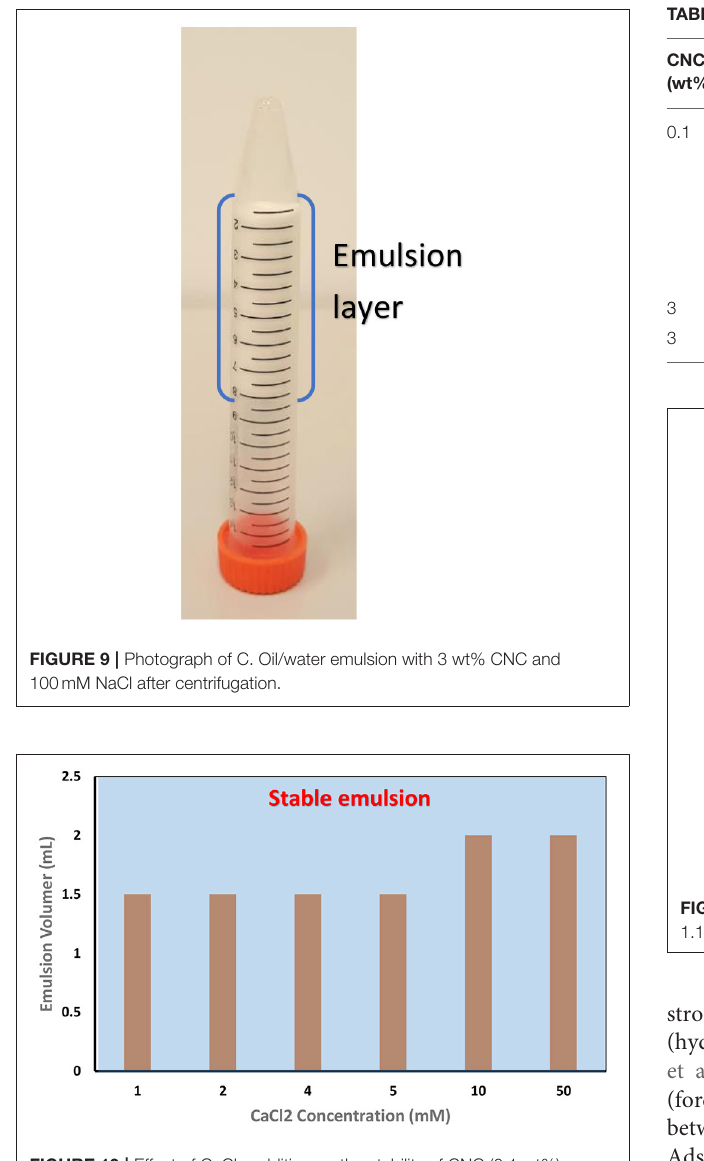
FIGURE 10 | Effect of CaCl 2 addition on the stability of CNC (0.1 wt%) stabilized C.Oil/Water emulsions.